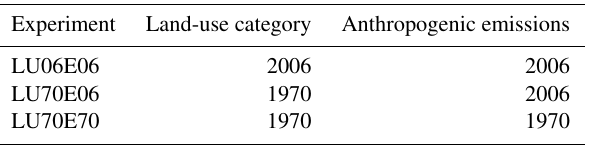
Table 2. Numerical experiments and corresponding urban land use and aerosol emissions.